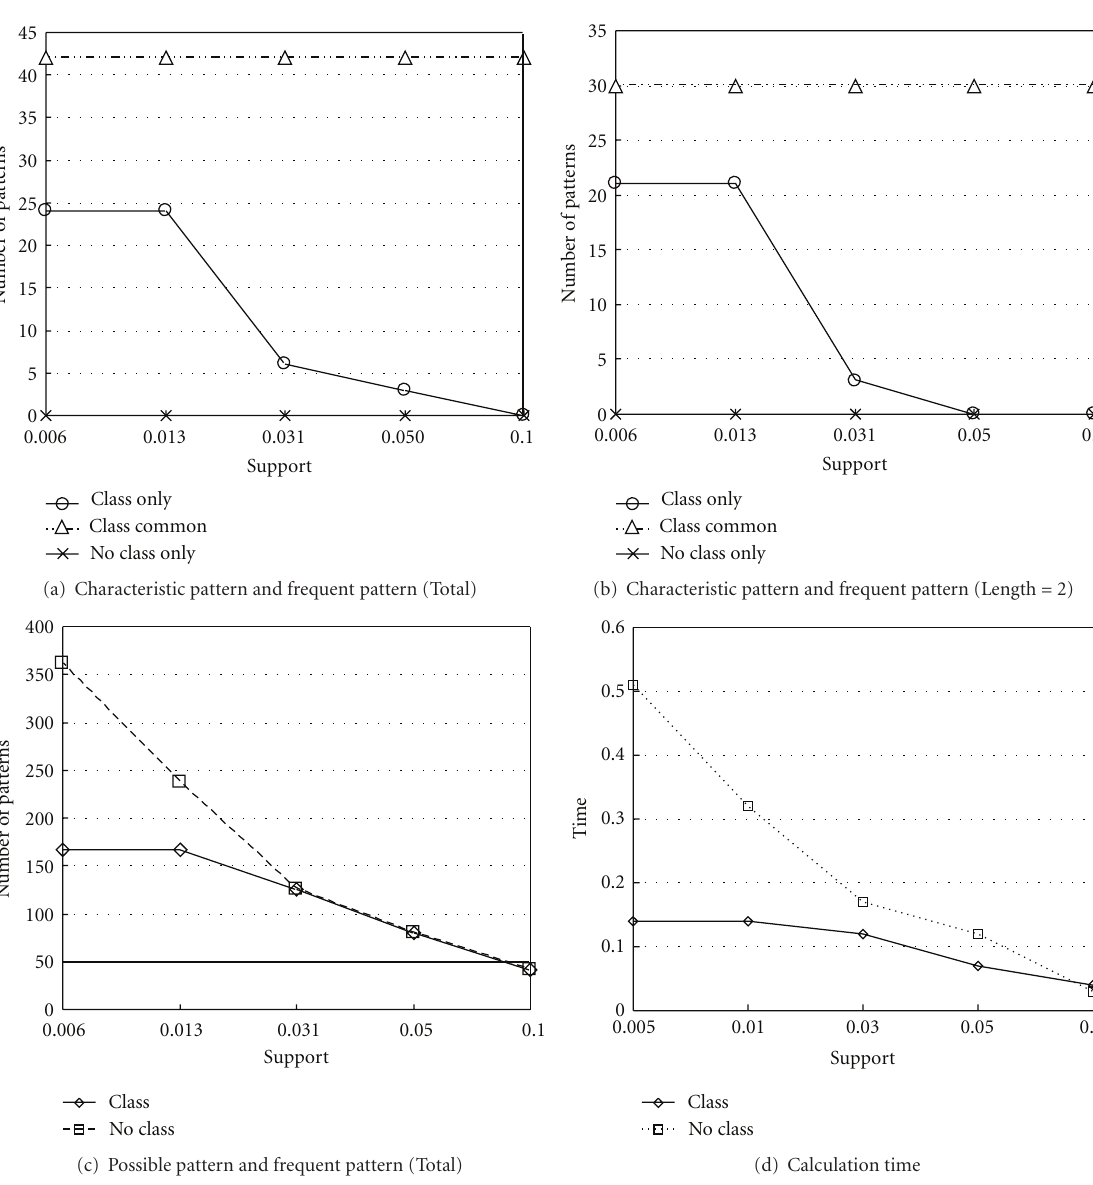
Figure 4: Experimental result in the case of the data set